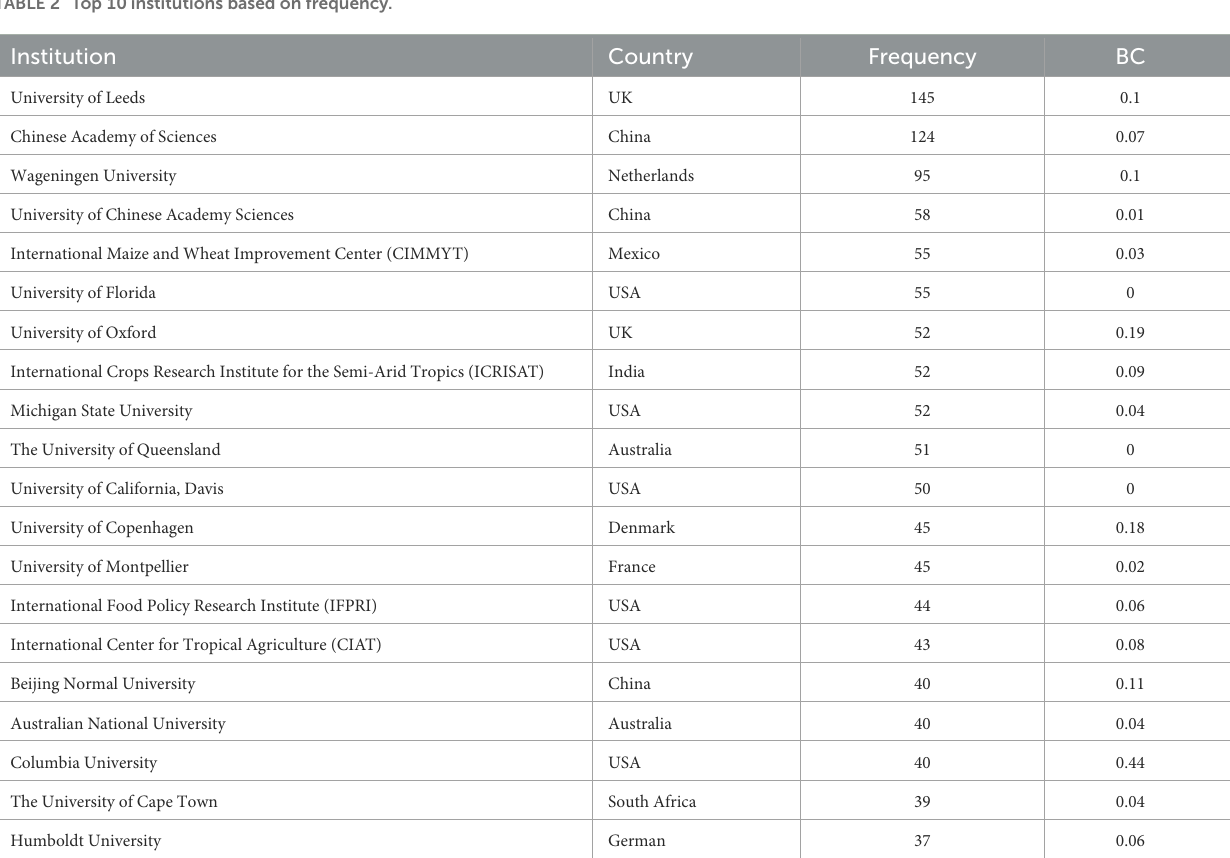
TABLE 2 Top 10 institutions based on